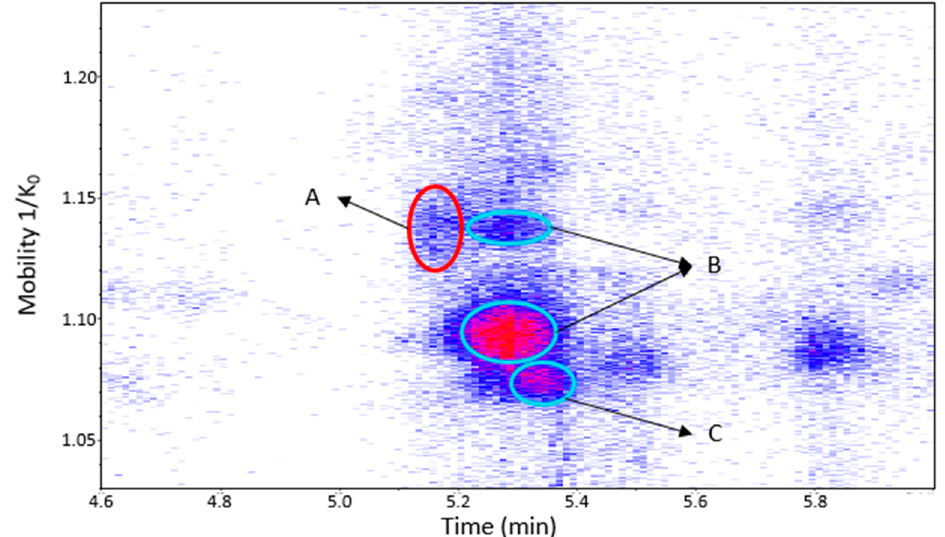
Figure 9. UHPLC − ESI ( − ) − TIMS − QTOF − MS/MS analysis of grape seed extract: heat map showing the mobility versus Rt for the mass range of m / z 577.1–577.2. Ellipses on the heat map mark the main spots. A: dehydrodicatechin of β -configuration formed from (+)-catechins. B: protomers of procyanidin B1. C: procyanidin B3. Full details are available on Table S2 in peaks 1 and 2 of grape seed extract.